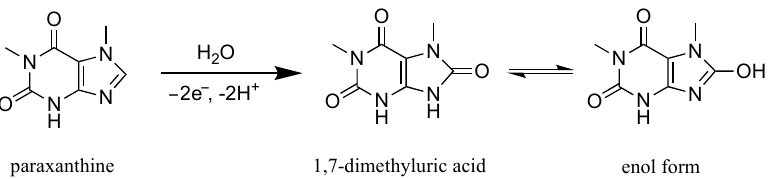
Scheme 1. Overall proposed oxidation mechanism of paraxanthine in 0.1 M H 2 SO 4 on the GC electrode.